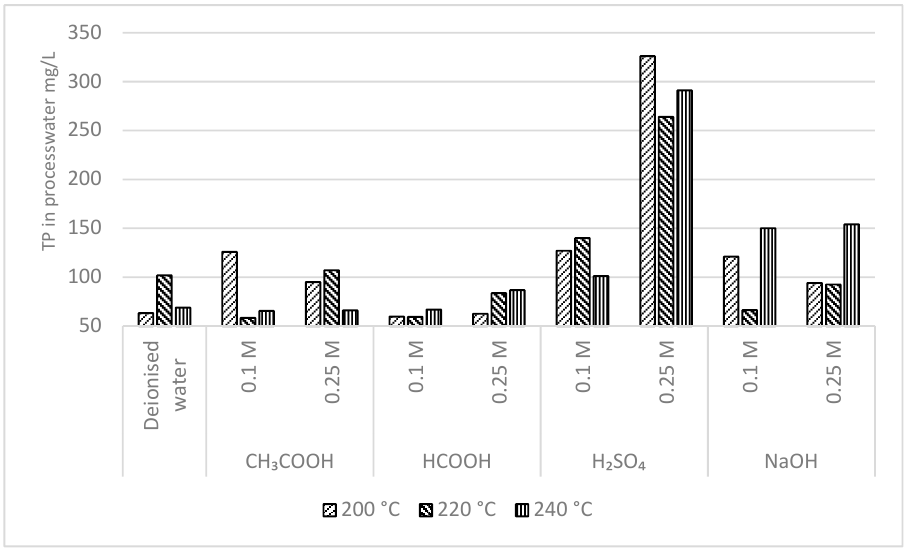
Figure 5. TP concentration of the process-water.